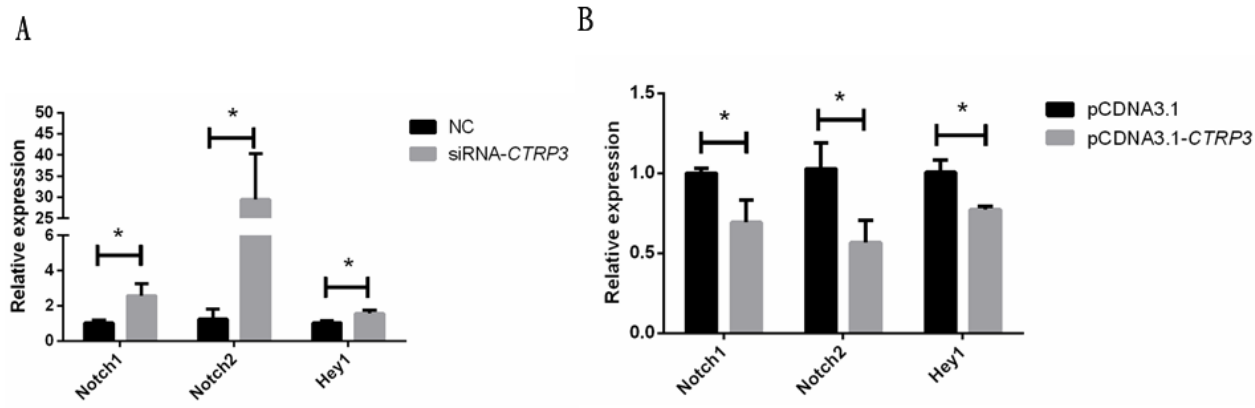
Figure 6. Effect of CTRP3 gene on the expression of Notch signaling pathway related genes. (A) The mRNA level of Notch1 , Notch2 , and Hey1 was detected by qPCR in myoblasts transfected with siRNA- CTRP3 or NC at day 3 of DM. (B) The mRNA levels of Notch1 , Notch2 , and Hey1 were detected by qPCR in myoblast transfected with pCDNA3.1-CTRP3 or pCDNA3.1 at day 3 of DM. Results are expressed as mean±standard error of the mean (n = 3). * p<0.05. CTRP3 , C1q and tumor necrosis factor-related protein 3; Notch1 , notch receptor 1; Notch2 , notch receptor 2; Hey1 , hairy/enhancer-of-split related with YRPW motif 1; qPCR, quantitative polymerase chain reaction; NC, negative control; DM, differentiation